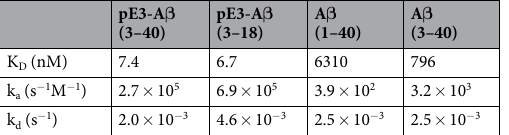
Table 1. Murine PBD-C06 Binding to Monomeric A β